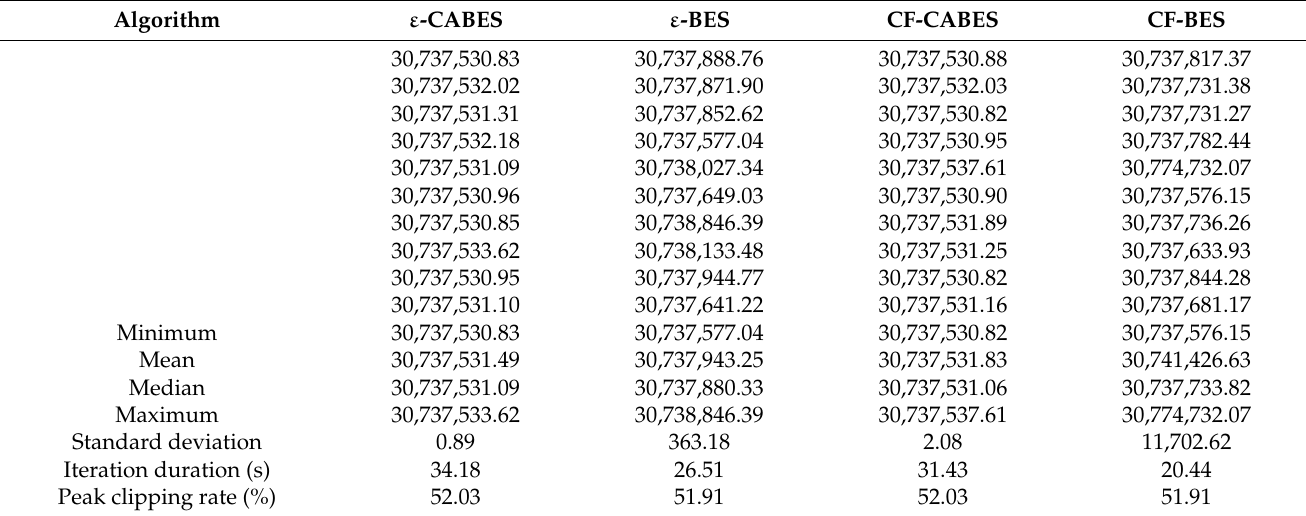
Table 7. Comparison of operation results of different algorithms for Dahuofang Reservoir.